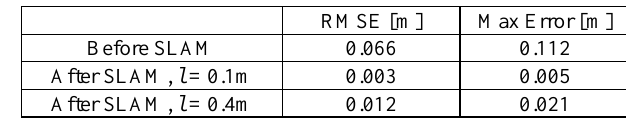
Table 3: Error in estimated trajectory for various l